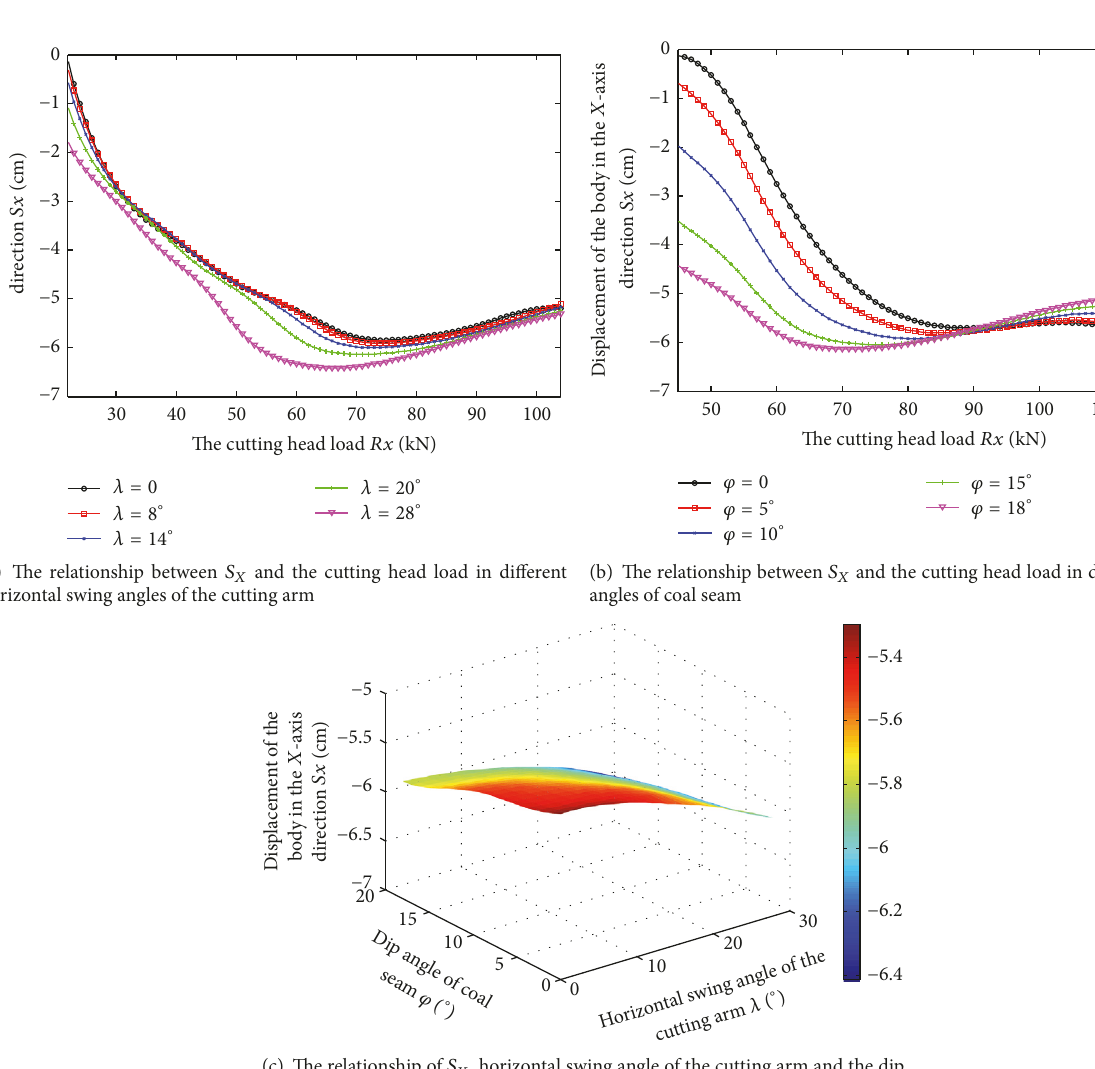
(c) The relationship of 𝑆 𝑋 , horizontal swing angle of the cutting arm and the dip angle of coal seam Figure 11: The response results of displacement of the body in the 𝑥 -axis direction 𝑆 𝑋